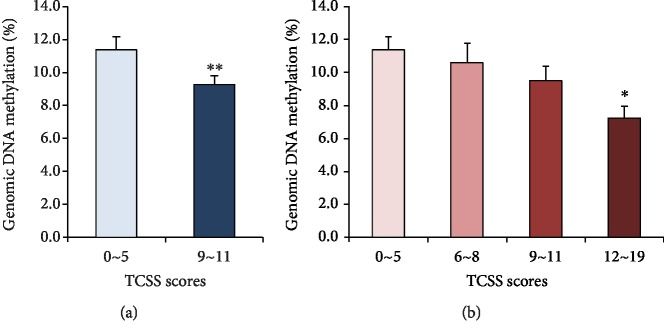
The level of genomic DNA methylation in different groups. (a) The level of genomic DNA methylation was lower in DPN (6~19 points) group compared with non-DPN (0~5 points) group (DPN, n = 100; non-DPN, n = 86, ∗p < 0.05, compared with non-DPN, Mann-Whitney U test). (b) Dividing the population into 4 subgroups according to TCSS scores, the level of genomic DNA methylation went down as TCSS score increased (TCSS score: 0~5 points, n = 86; 6~8 points, n = 36; 9~11 points, n = 35; 12~19 points, n = 29, ∗p < 0.05, compared with non-DPN, Kruskal-Wallis ANOVA).